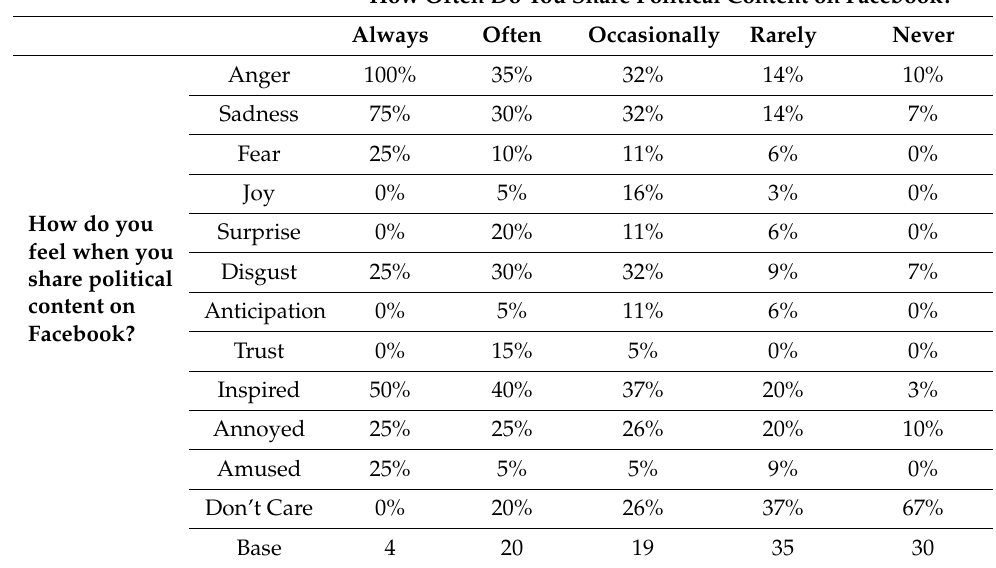
Table 11. Emotional interaction via online political